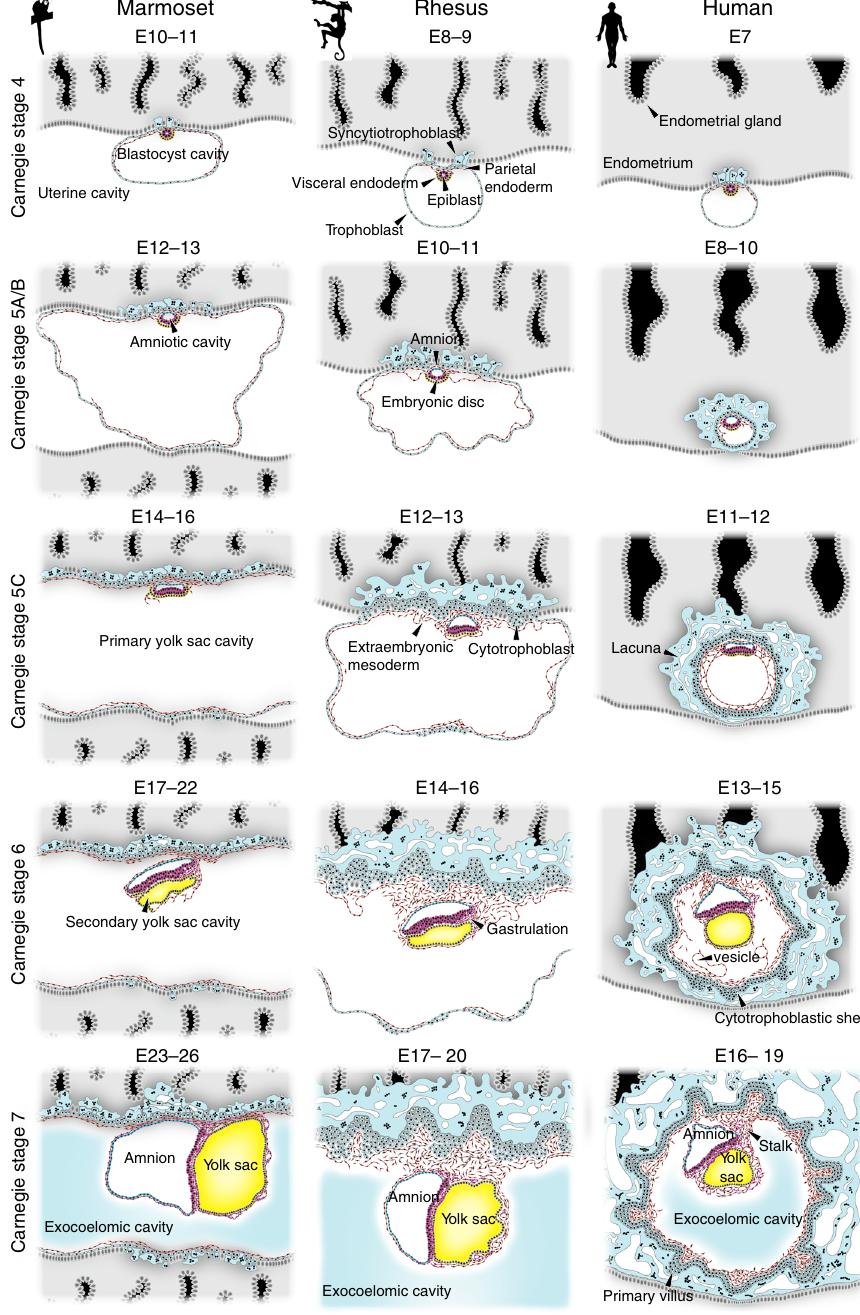
Fig. 2 Yolk sac formation in primates. Embryonic stages of common marmoset ( Callithrix jacchus ), rhesus monkey ( Macaca mulatta ) and human ( Homo sapiens ) are depicted in Carnegie stages and embryonic day (E) for each species. The de fi nitive, secondary yolk sac is highlighted in yellow. Drawings are based on representative histological sections of common marmoset 82,83 , rhesus 81 and human 71,72,87,161,162